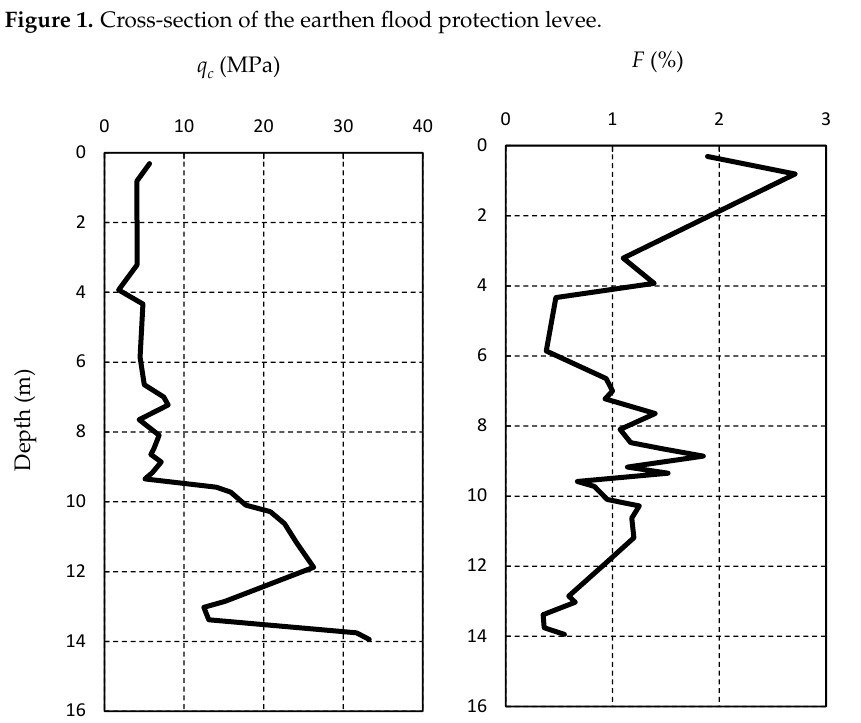
Figure 2. Example of profiles of tip resistance q c and normalized friction ratio F with depth.